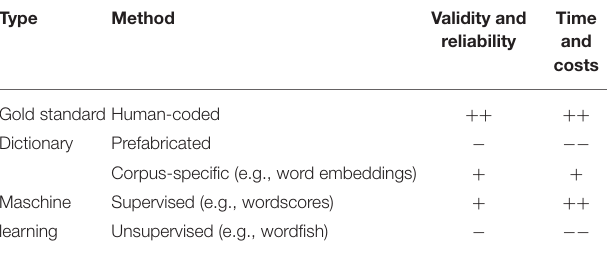
TABLE 1 | Overview of various sentiment classification